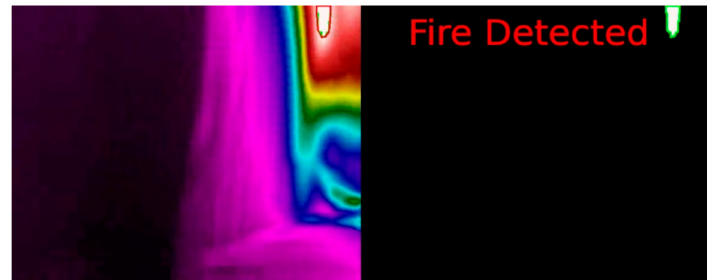
Figure 14. Erroneous detection of fire in the Teresa test.